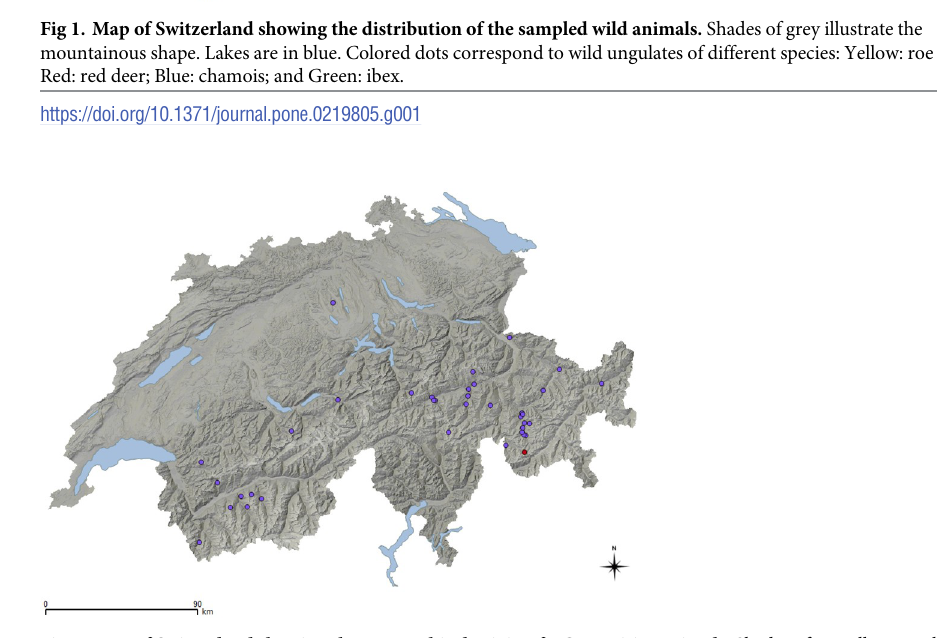
Fig 2. Map of Switzerland showing the geographical origin of PCR positive animals. Shades of grey illustrate the mountainous shape. Lakes are in blue. Violet dots correspond to wild ungulates positive for benign strains and red dots to wild ungulates positive for virulent